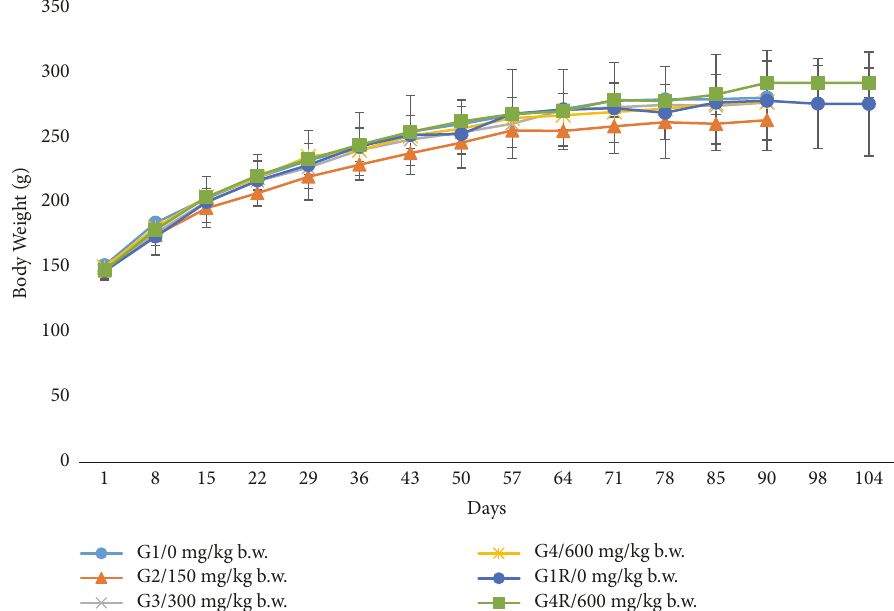
Figure 5: Effect of ubiquinol acetate on body weights in female rats. Mean body weights for female rats during a 90-day oral (gavage) toxicity study. The values are presented as means ± standard deviation (10 rats/sex/group for main study group and 5 rats/sex/group for recovery